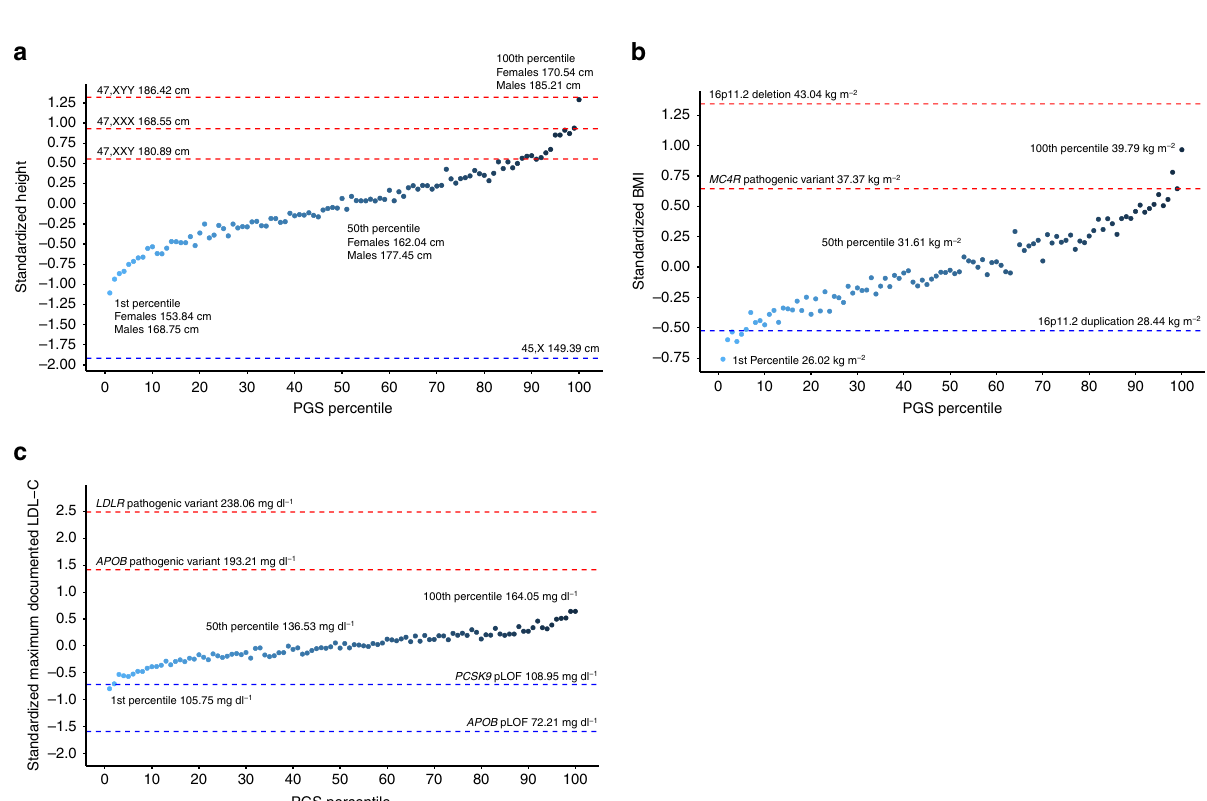
Fig. 1 Comparison of PGS and RGDs across three quantitative traits. Mean height ( a ), BMI ( b ), and LDL-C ( c ) in variant negative individuals by percentile of the polygenic score. Points are colored from light to dark blue with an increasing PGS. Mean phenotypes of the 1st, 50th, and 100th percentile bins are indicated in non-standardized units. For comparison, the mean phenotype of RGD-causing variants are indicated as red (positive effect) and blue (negative effect) dashed